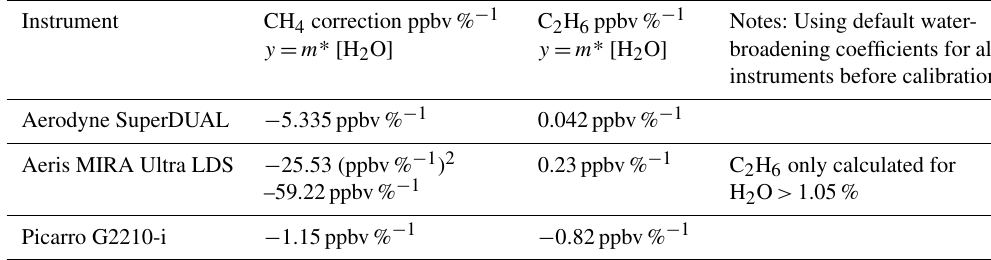
Table 1. Summary of water vapor corrections derived for each